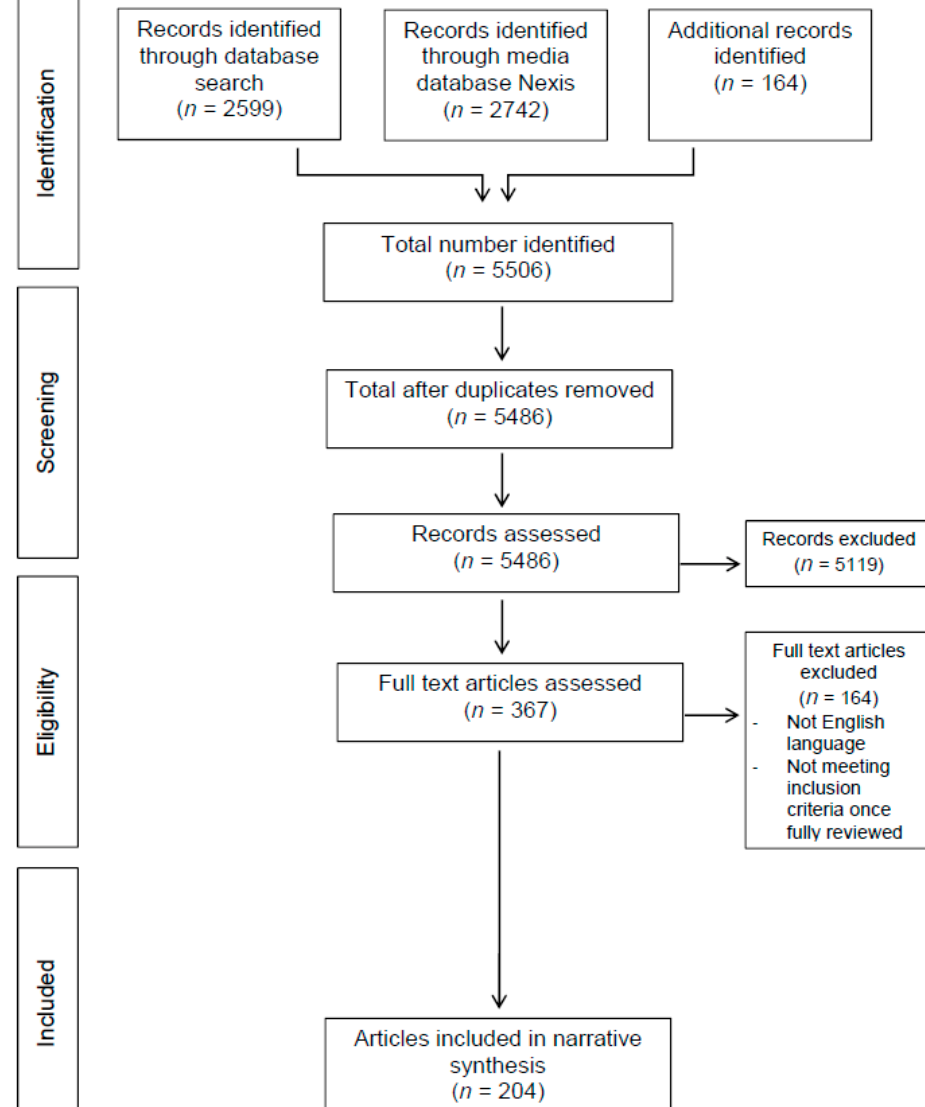
Figure 1. Systematic search strategy flow diagram.